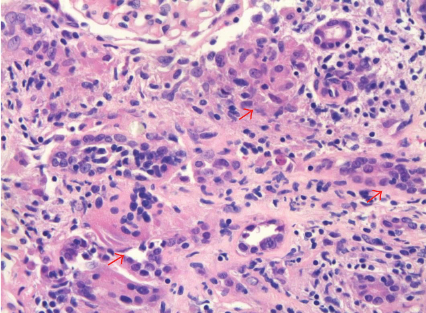
Figure 2: Renal Biopsy. Noncaseating granulomatous inflamma- tion. Aggregation of epithelioid histiocytes aggregation (arrows), mixed with lymphocytes, forming granuloma. Hematoxylin and eosin (HE) stain 400x.